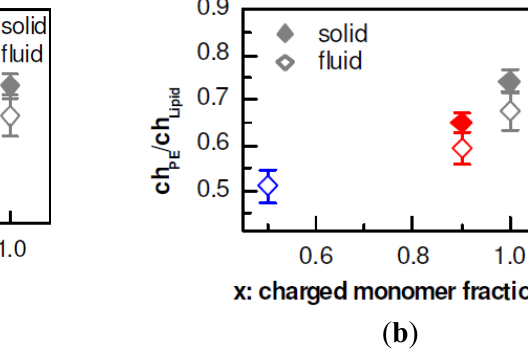
Figure 7. Ratio of charged adsorbed PE monomers to charged lipid molecules ch as function of the surface charge or linear charge density, respectively. Each value of ch /ch shown is the average of all GID measurements taken from the lipid phase PE Lipid indicated. ( a ) DODA DPPC monolayers with adsorbed PSS. ( b ) DODA monolayers y 1 − y with adsorbed PE (PSS, P–TrisAA –rand–AMPS with x = 0.9, 0.5). Symbol x 1 − x